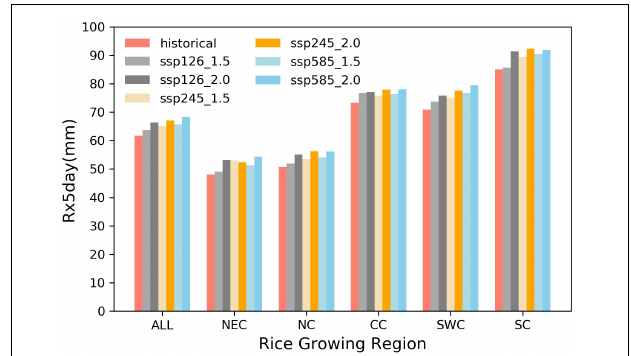
FIGURE 8 | The same as Figure 6 but for the changes in 5-day maximum precipitation (Rx5day) (mm).